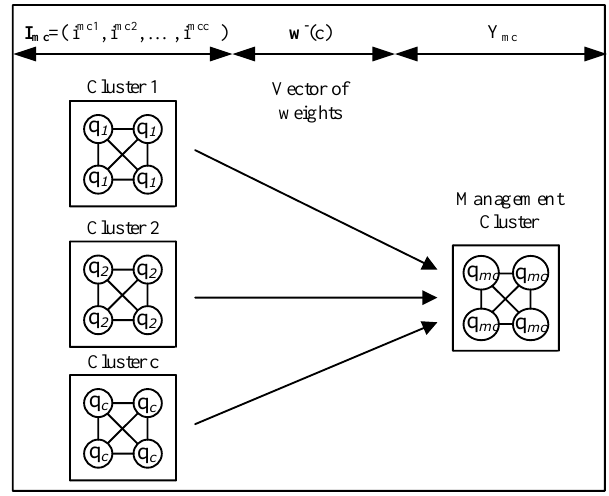
Figure 5. Deep Learning Management Cluster.